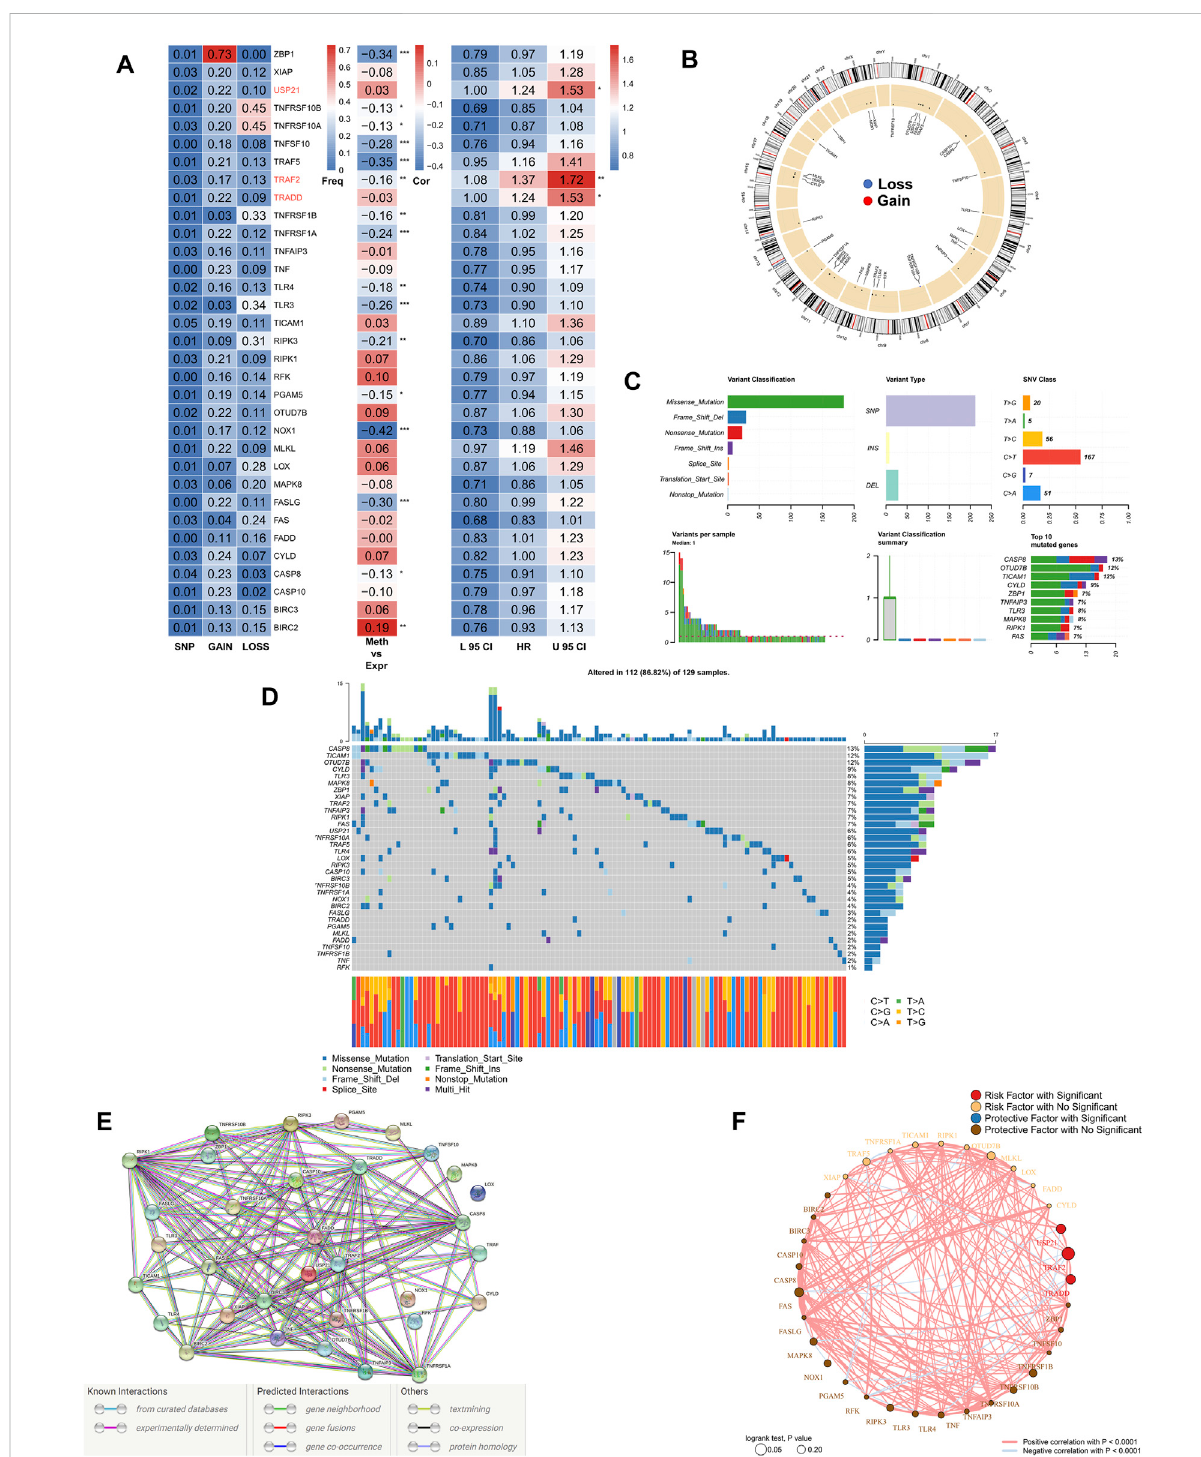
FIGURE 1 GenomicmappingofNRGsinCOADpatients. (A) .HeatmapshowinggenomicchangesandhazardratiosofNRGsinTCGA-COADcohort;from lefttoright:correlationbetweenmutationandCNVfrequenciesforNRGs,modi fi cationsinDNAmethylationandexpressionofNRGs,univariateCox regression analysis showing risk ratios for NRGs; * p < 0.05, ** p < 0.01, *** p < 0.001; (B) . Circle plot demonstrating CNV events in NRGs on chromosomes; (C) . Summary of CNV events in NRGs in TCGA-COAD cohort; (D) . Oncoplot showing the mutational mapping of NRGs; (E) . String PPI network of NRGs; (F) . Correlation network of